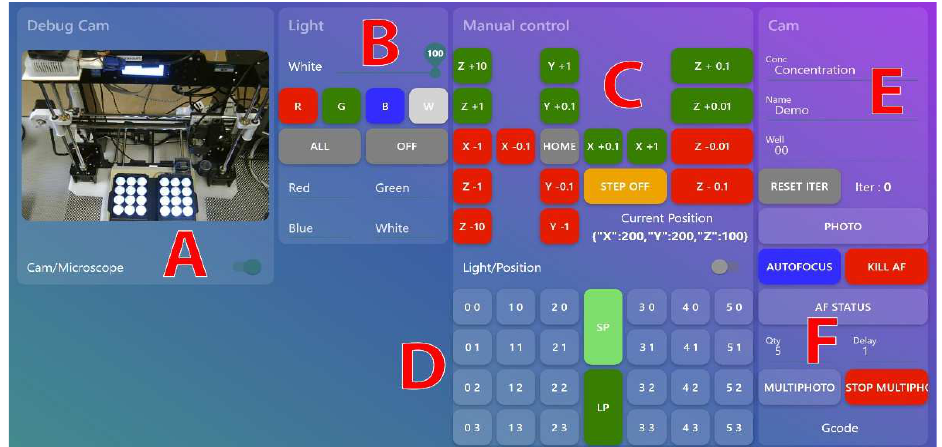
Figure 6. Node-RED dashboard. The graphical user interface is composed of four panels (debug cam, light, manual control, and cam). The first panel ( A ) allows access to the security camera (Cam) to remotely view the machine to ensure its proper working or to access the microscope image (Microscope). The second panel ( B ) allows controlling the light. The control panel ( C ) allows manually moving the camera on its three axes and returns the current position of the camera. The plate menu ( D ) allows moving the camera to various pre-programmed positions, and turning on the light in individual wells. The “SP” (safe position) button sends automatically the camera to the upper right corner of the robot and advances the plate towards the user, thus facilitating the installation of multi-well plates, while the “LP” (last position) button returns the camera to its previous position (in case the user accidentally moves the camera). The panel ( E ) allows capturing and naming of images. Finally, panel ( F ) performs the